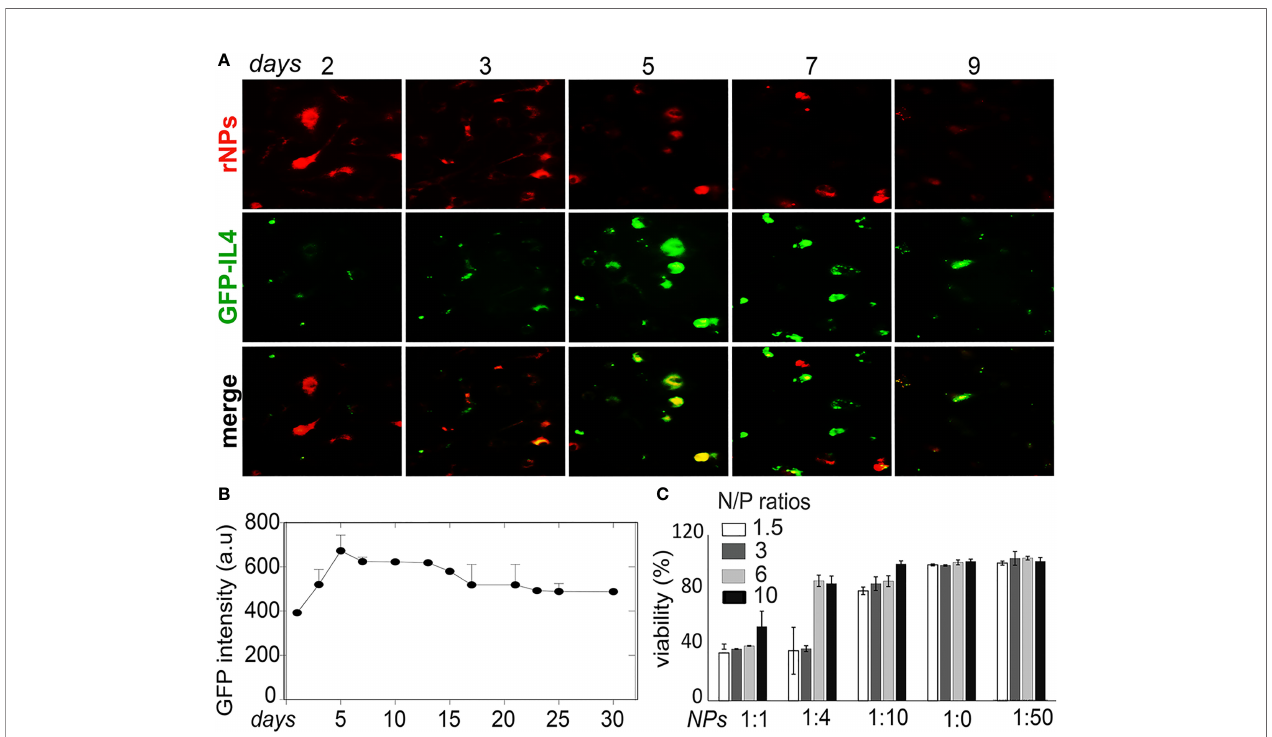
FIGURE 6 | Stability of IL-4pDNA-NPs transfection. (A) NPs were labeled with red dye Rhodamine (rNPs) and loaded with IL-4-pDNA/GFP (IL-4pDNA/GFP-rNPs). MDM were treated with IL-4pDNA/GFP-rNPs for 2, 3, 5, 7 and 9 days to evaluate the correlation of internalized rNPs and GFP expression in MDM. The greatest intracellular rNPs accumulation (A, red) was seen at day 2, followed by gradual reduction over 9 days. A peak level of GFP+ intensity (A, green) was obtained at day 5 with continual expression up to 9 days. (B) GFP expression was detected over the next 30 days. (C) Speci fi c toxicity of different ratios of NPs to culture media for various concentrations of IL-4pDNA was evaluated by a viability assay. No toxicity was observed at NPs to media ratios of 1:20 and 1:50. Error bars represent the standard error of the mean